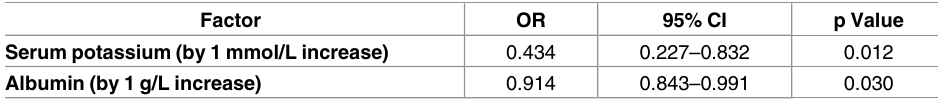
Table 5. Predictors of Patient Survival by Logistic Regression